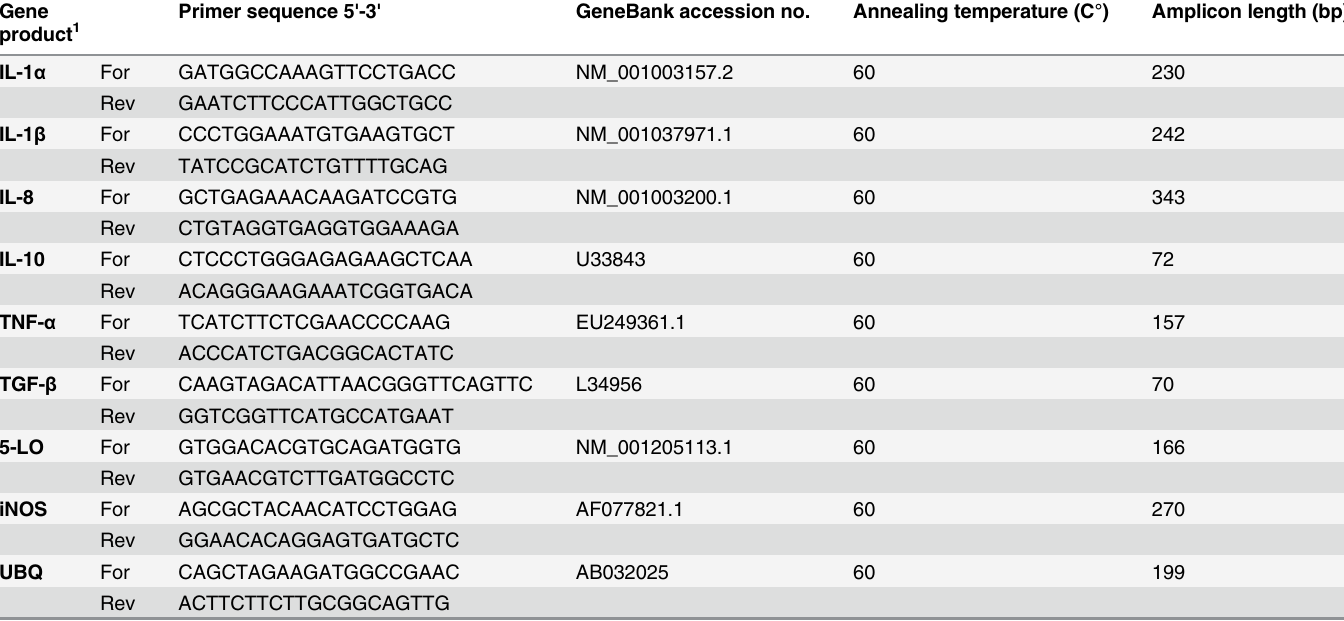
Table 1. Detailed primers and conditions used for real-time PCR